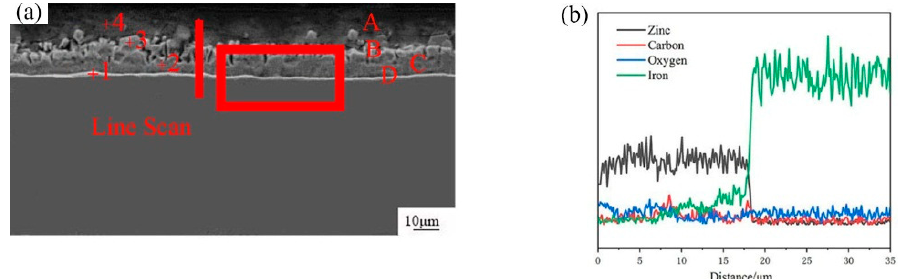
Figure 3. ( a ) SEM micrograph of interfacial microstructure of cross-section image of hot-dip galvanized 45 steel; ( b ) EDS line scan of cross-section of hot-dip galvanized 45 steel marked in (a).